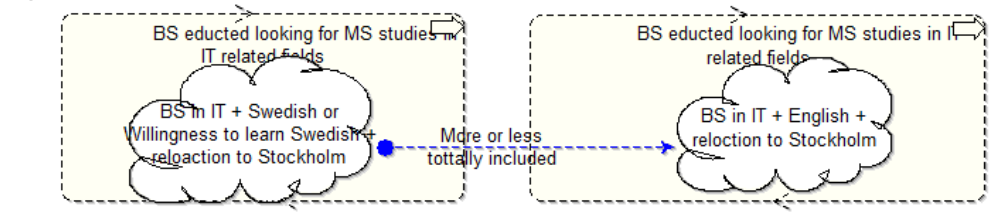
Figure 6. Changes in the structure of an inbound